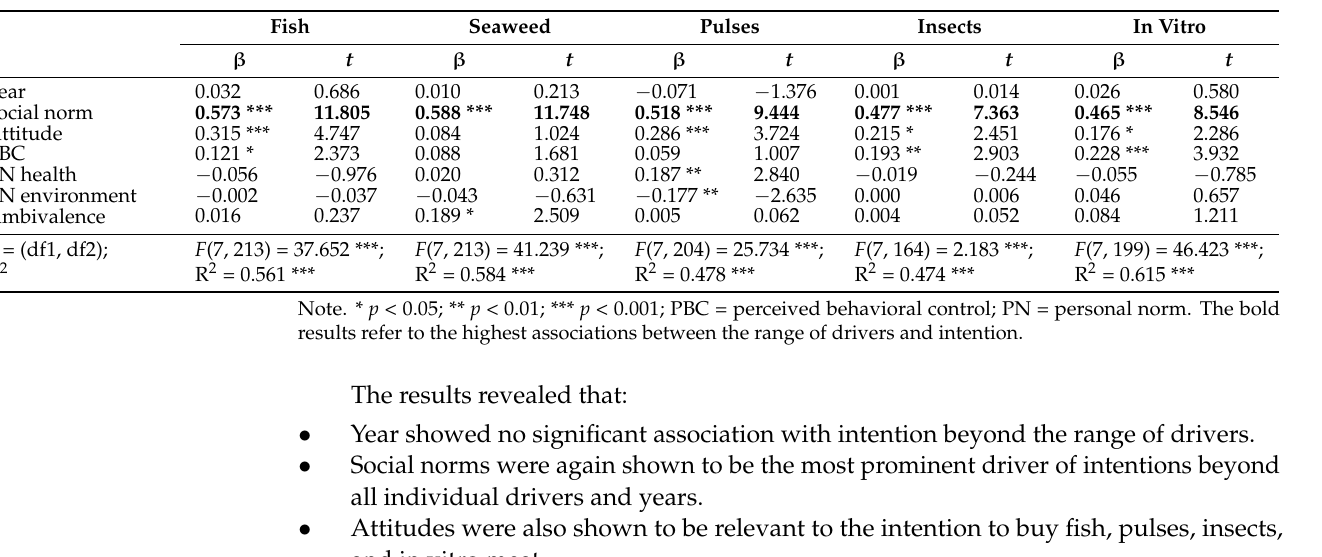
Table A1. Hierarchical regression analyses on the pooled data with year (dummy) and drivers as the independent variables and intention as the dependent variable for all alternative